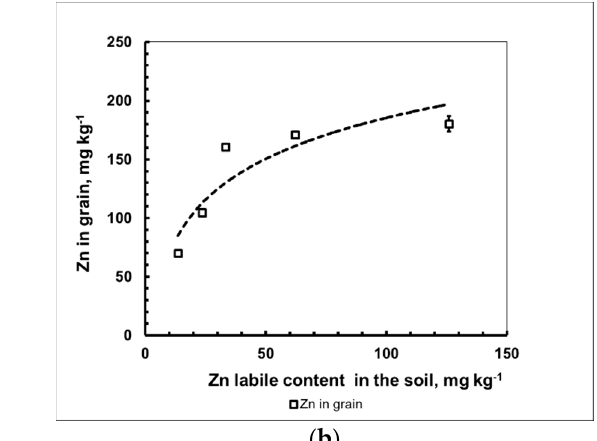
Figure 2. Dependence of the mass concentration of Zn in barley straw on the total amount ( a ) and labile form ( b ) of the metal in the soil (mean value ± standard deviation; n = 3).